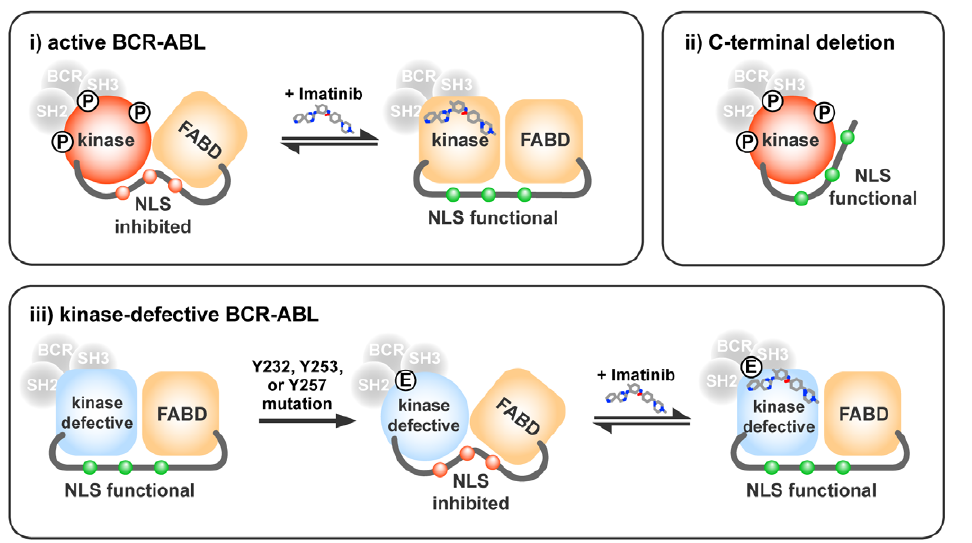
Figure 8. A model for the regulation of BCR-ABL nuclear import through conformational interplay between the kinase domain, the FABD and the NLS region. (i) Tyrosine phosphorylation at Y232, Y253 or Y257 causes the kinase domain to adopt a conformation that affects the folding of the C-terminal region and leading to the inhibition of the NLS function (indicated by the red color of the three nuclear localization signals depicted as small circles embedded in a proline-rich linker between the kinase domain and the F-actin binding domain, FABD). The kinase domain autophosphorylation-induced occlusion of the NLS also requires the C-terminal region beyond the third NLS (NLS-3) and including an intact helix-3 of the FABD. Binding of imatinib reverts the kinase domain back to the ‘‘DFG-Asp out’’ N-lobe conformation that alters the folding of the C-terminal region to un-mask the NLS (indicated by the green color of the three nuclear localization signals). (ii) Deletion of C-terminal sequences beyond the NLS-3 unmasks the NLS despite the kinase domain autophosphorylation. (iii) Mutation of Y232, Y253 or Y257 to glutamic acid (E) also alters the kinase domain conformation to trigger the inhibition of the NLS function. The NLS-inhibitory effect of the tyrosine to glutamic acid substitutions can be observed in a kinase-defective BCR 63 -ABL. Binding of imatinib induces the ‘‘DFG-Asp out’’ conformation of the kinase domain [30], and this imatinib- bound conformation can override the effect of the glutamic acid substitution to re-activate the NLS function.